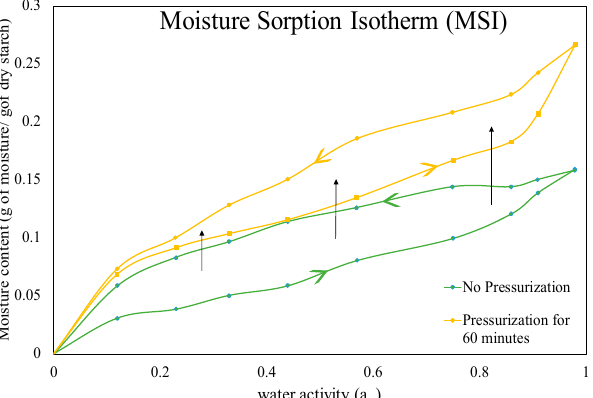
Figure 4. Change in the hysteresis of starch observed after high pressure treatment (plotted using the data from Santos et al., 2014 [21]).